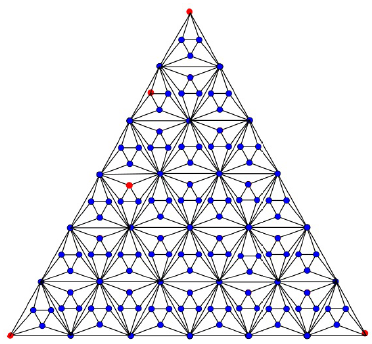
Figure 3. Third type of triangular hex-derived network ( THDN 3 ( 7 ) ).